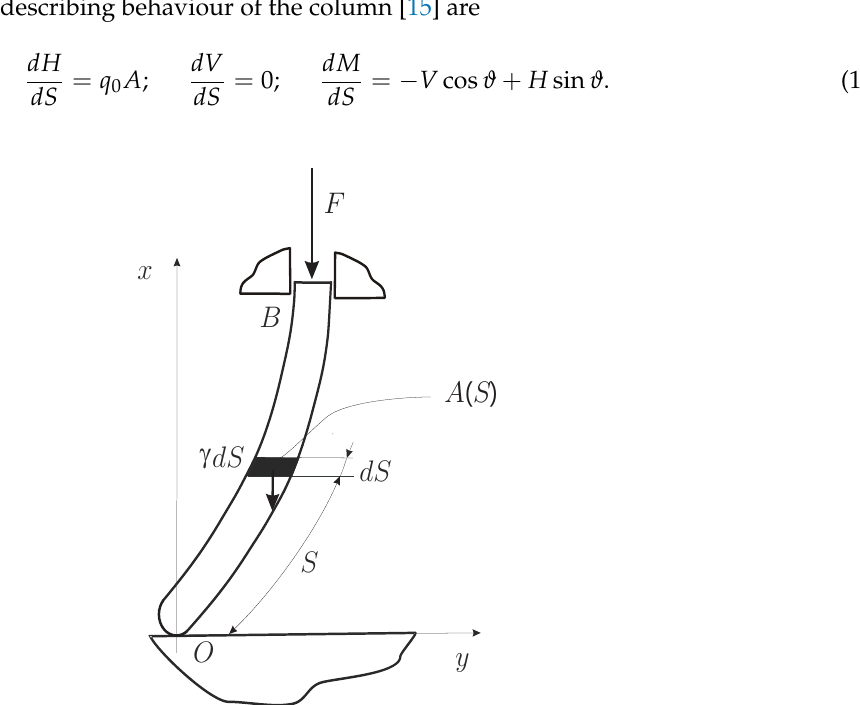
Figure 1. Coordinate system for the rod under self-weight and concentrated